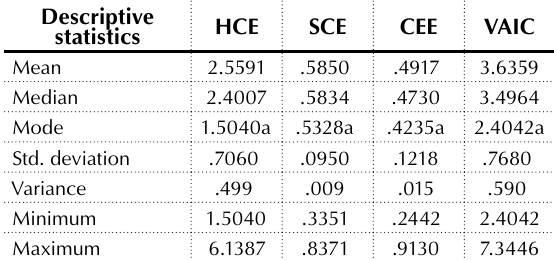
Table 2. Descriptive statistics of intellectual capital